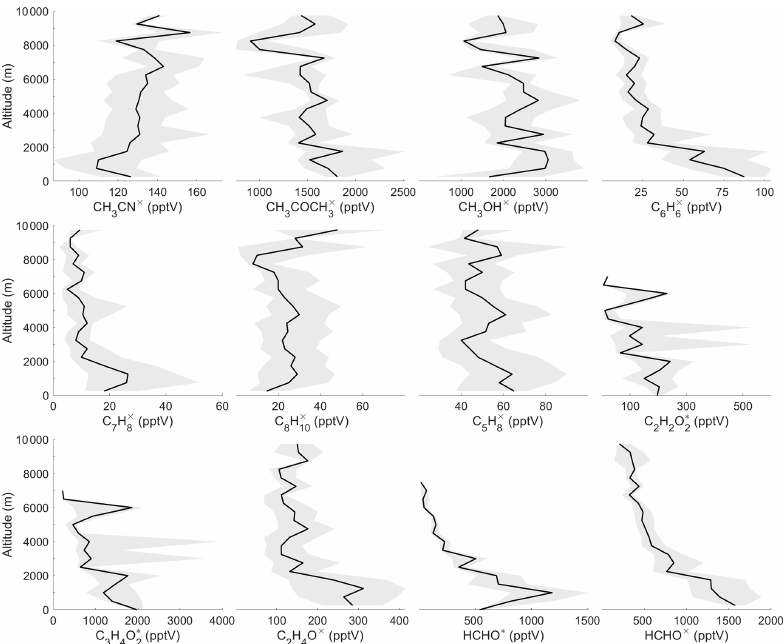
Figure 14. Variation of VOC versus altitude measured by the HKMS (labelled with x ) and the miniDOAS (labelled with ∗ ) instruments during EMeRGe over Europe. Shaded areas are the quartiles; solid lines represent median